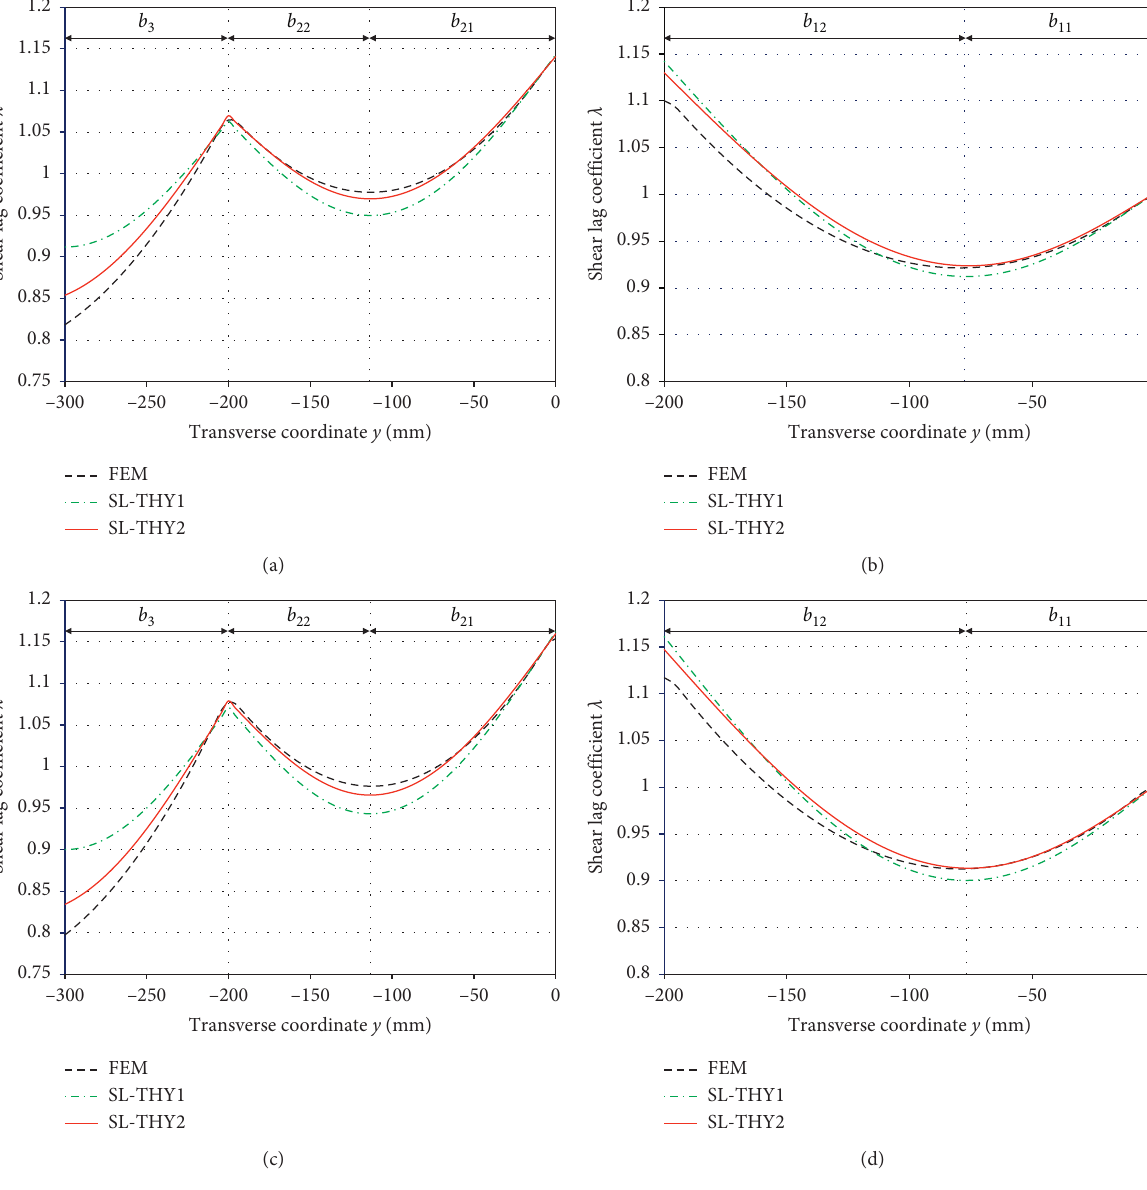
Figure 11: Shear lag coefficients of the fixed-end box girder. (a) Top flanges of midspan cross section ( x � 750mm). (b) Bottom flanges of midspan cross section ( x � 750mm). (c) Top flanges of 2/5-span cross section ( x � 600mm). (d) Bottom flanges of 2/5-span cross section ( x �